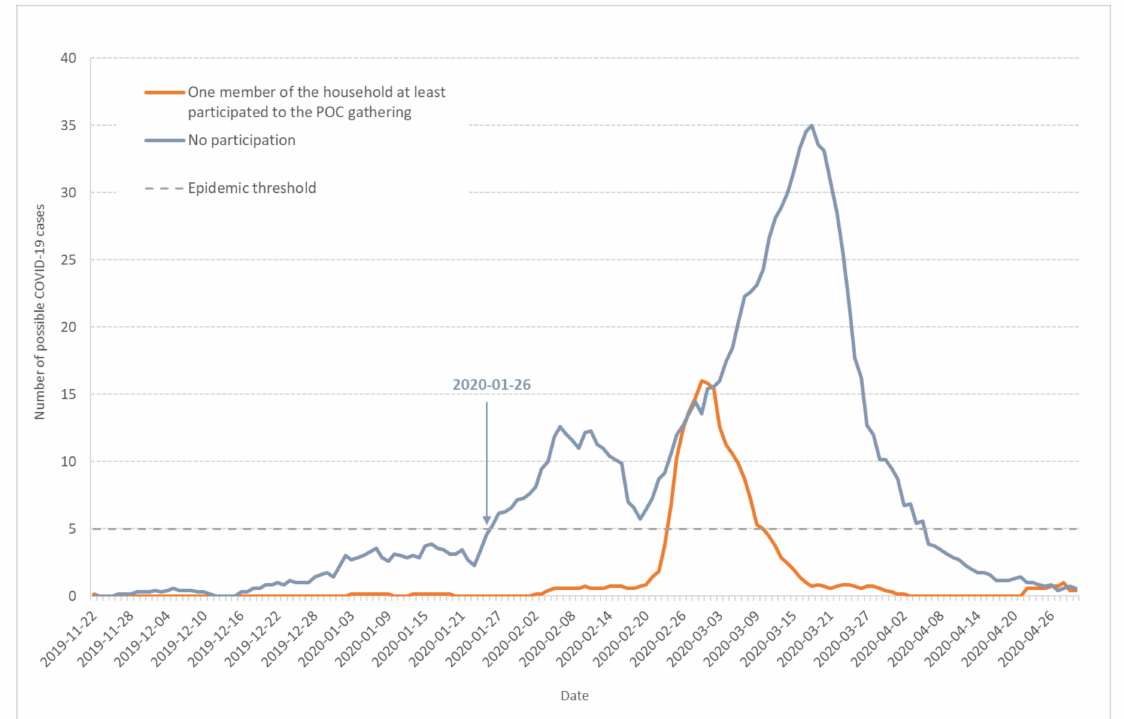
Figure 6. Seven-day moving average of daily incidence for possible COVID-19 cases among Haut-Rhin households. Orange line corresponds to households in which at least one member participated to the POC gathering in Mulhouse (17–21 February 2020) and grey line to households without participants to the POC